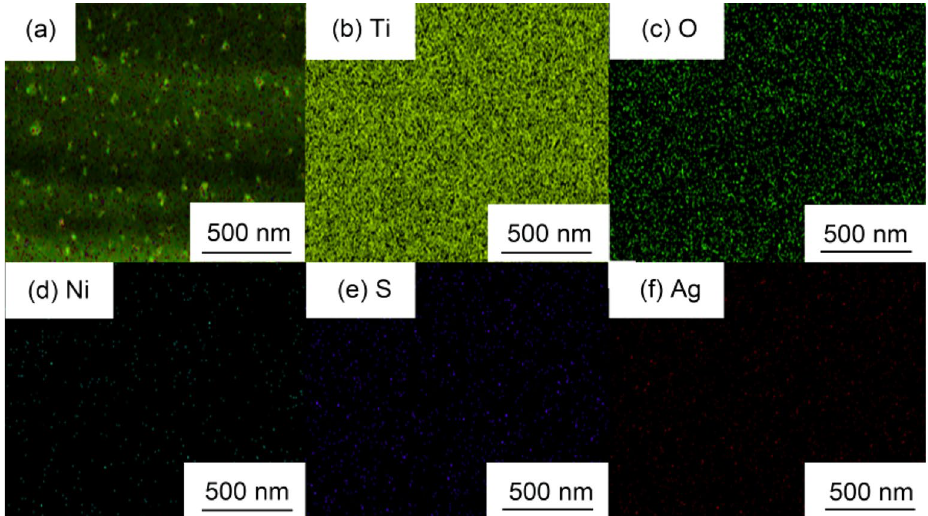
Figure 8. Elemental distributions (Ti, O, Ni, S and Ag) of the Ag/NiS/TiO 2 nanocomposite with 6 NiS impregnation-deposition cycles performed at a AgNO 3 concentration of 0.1 M.